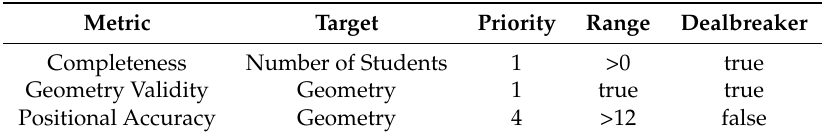
Figure 10. Thematic Map School_Culture exposing the date of the school’s inception, including a data quality layer exposing a good coverage with green and a bad coverage with red. Contrary to Figure 9, aside from the positional accuracy, only one attribute, the inception is of major interest in this thematic map. Further data lower priority quality metrics may be applied. Table 4. Minimum Requirement Profile: For the thematic map with the number of students only the geoposition and the attribute number of students is relevant. The thematic map can therefore be evaluated using this generic requirement profile.